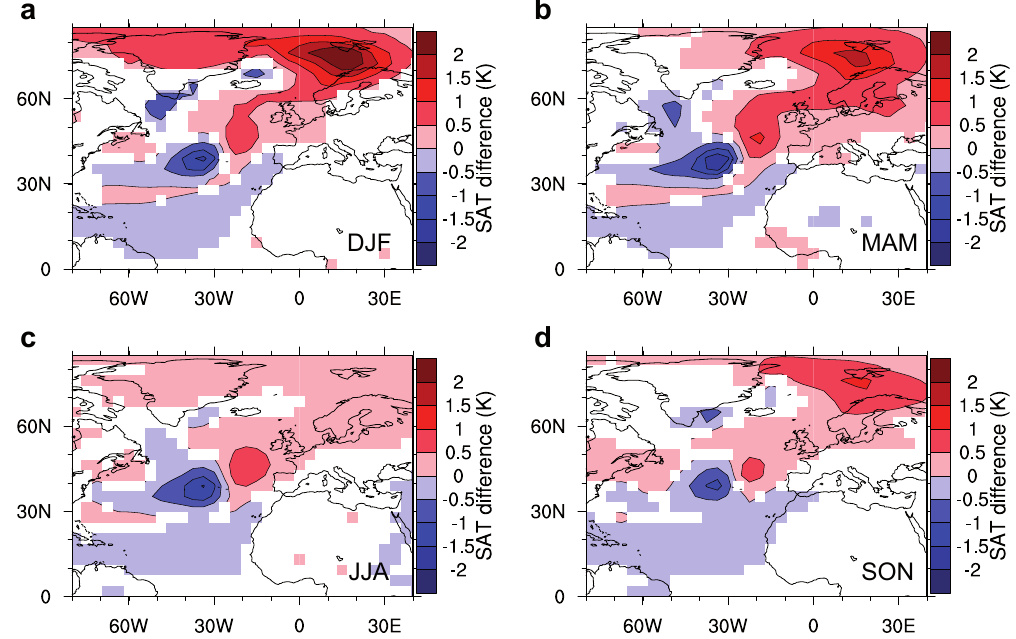
Fig. 10. Seasonal SAT response for the Type 3 transitions according to the first method: (a) winter (DJF), (b) spring (MAM), (c) summer (JJA), (d) autumn (SON). Only the values that are statistically significant at the 5% level based on the two-sided Student’s t-test are colored.